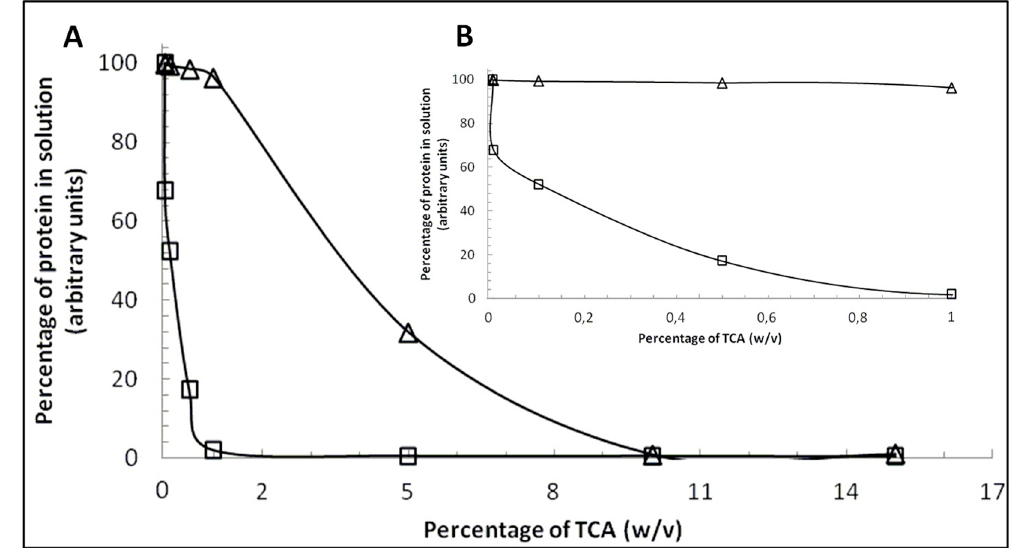
Figure 2. Panel ( A ): The percentage of protein in solution β -LG (open triangle) and β -CN (open square) after TCA-induced precipitation, expressed as w / v . Panel ( B ): Magnification of protein behavior at percentage of TCA from 0 to 1 ( w / v ).